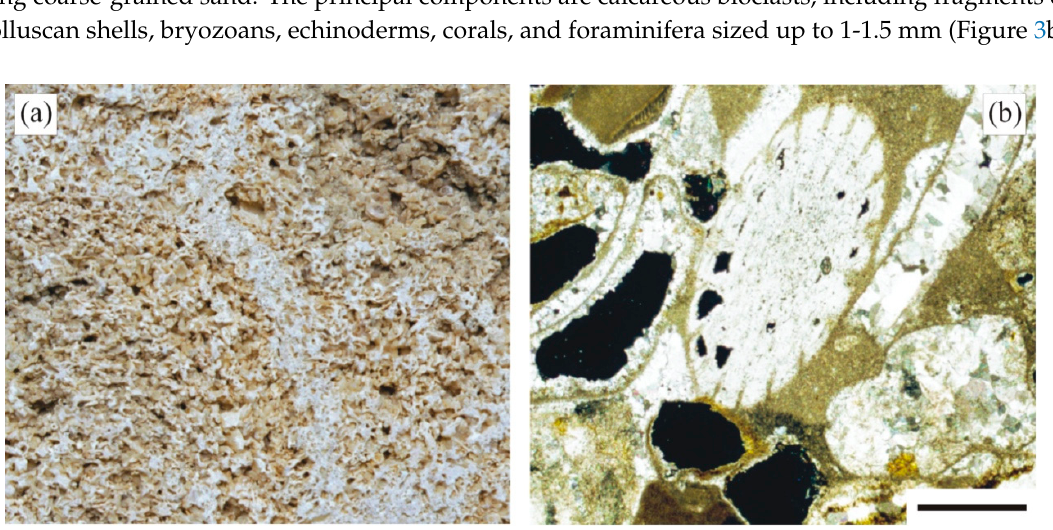
Figure 3 . ( a ) Fresh cut surface of a representative specimen of Pietra d’Aspra (not consolidated and not weathered, sample PA-TQ); ( b ) thin-section microphotograph of the same sample (scale bar = 0.5 mm).